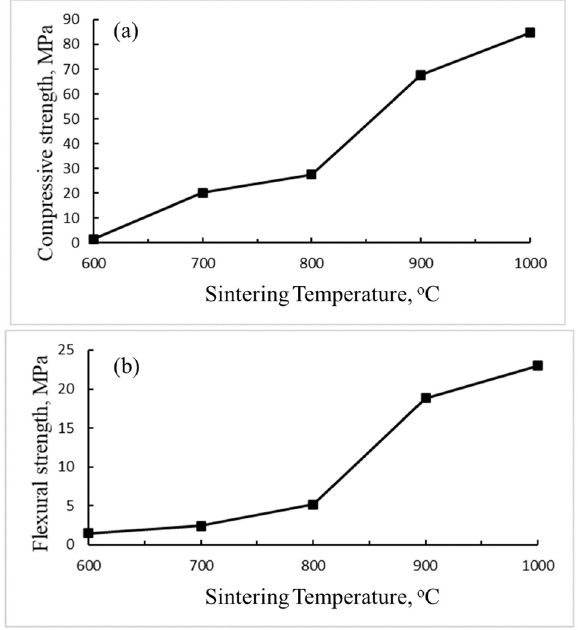
Figure 4. Mechanical strength of DC bricks sintered at different sintering temperatures, (a) compressive strength (b) flexural strength.